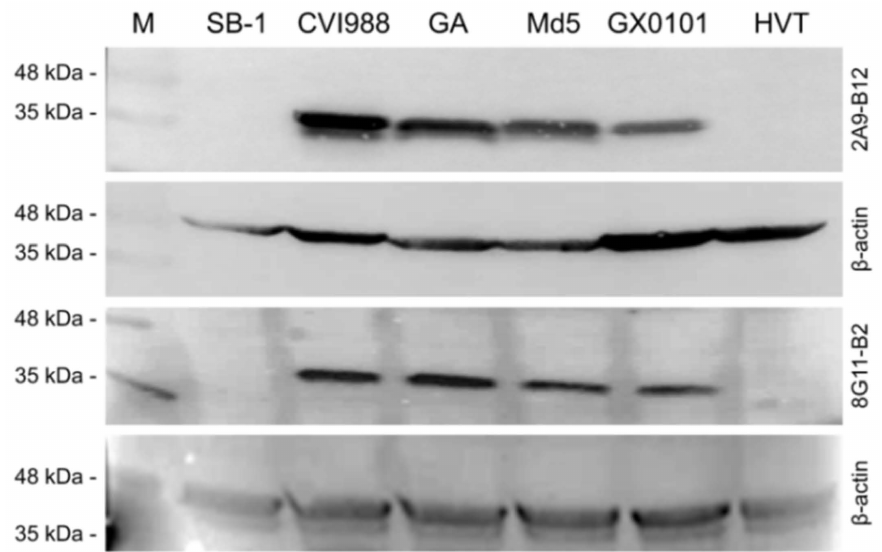
Figure 6. Western blot analysis of reactivity of mAbs 2A9-B12 and 8G11-B2 to the Meq proteins from MDV strains with different virulence. The reaction spectrums of newly developed Meq mAbs to dif- ferent types of MDV and HVT were determined by Western blot analysis. Meq, MDV − 1 oncoprotein. The chicken β -actin was used as protein loading control. M, protein molecular weight